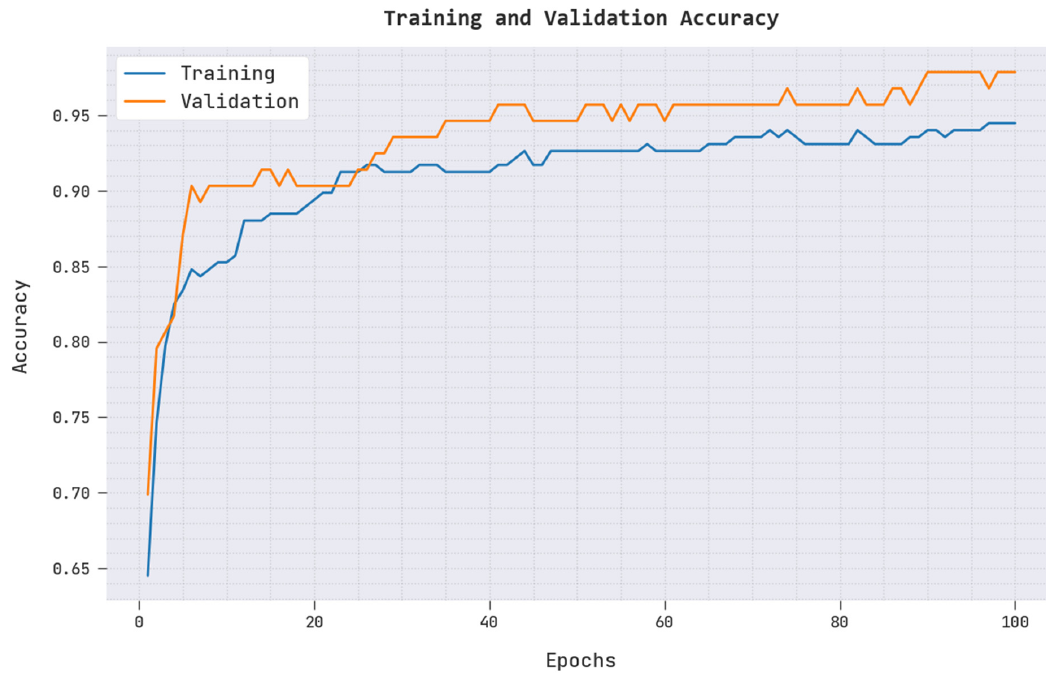
Figure 4. TRAC and VAAC of ARAC ‐ AOADL model.